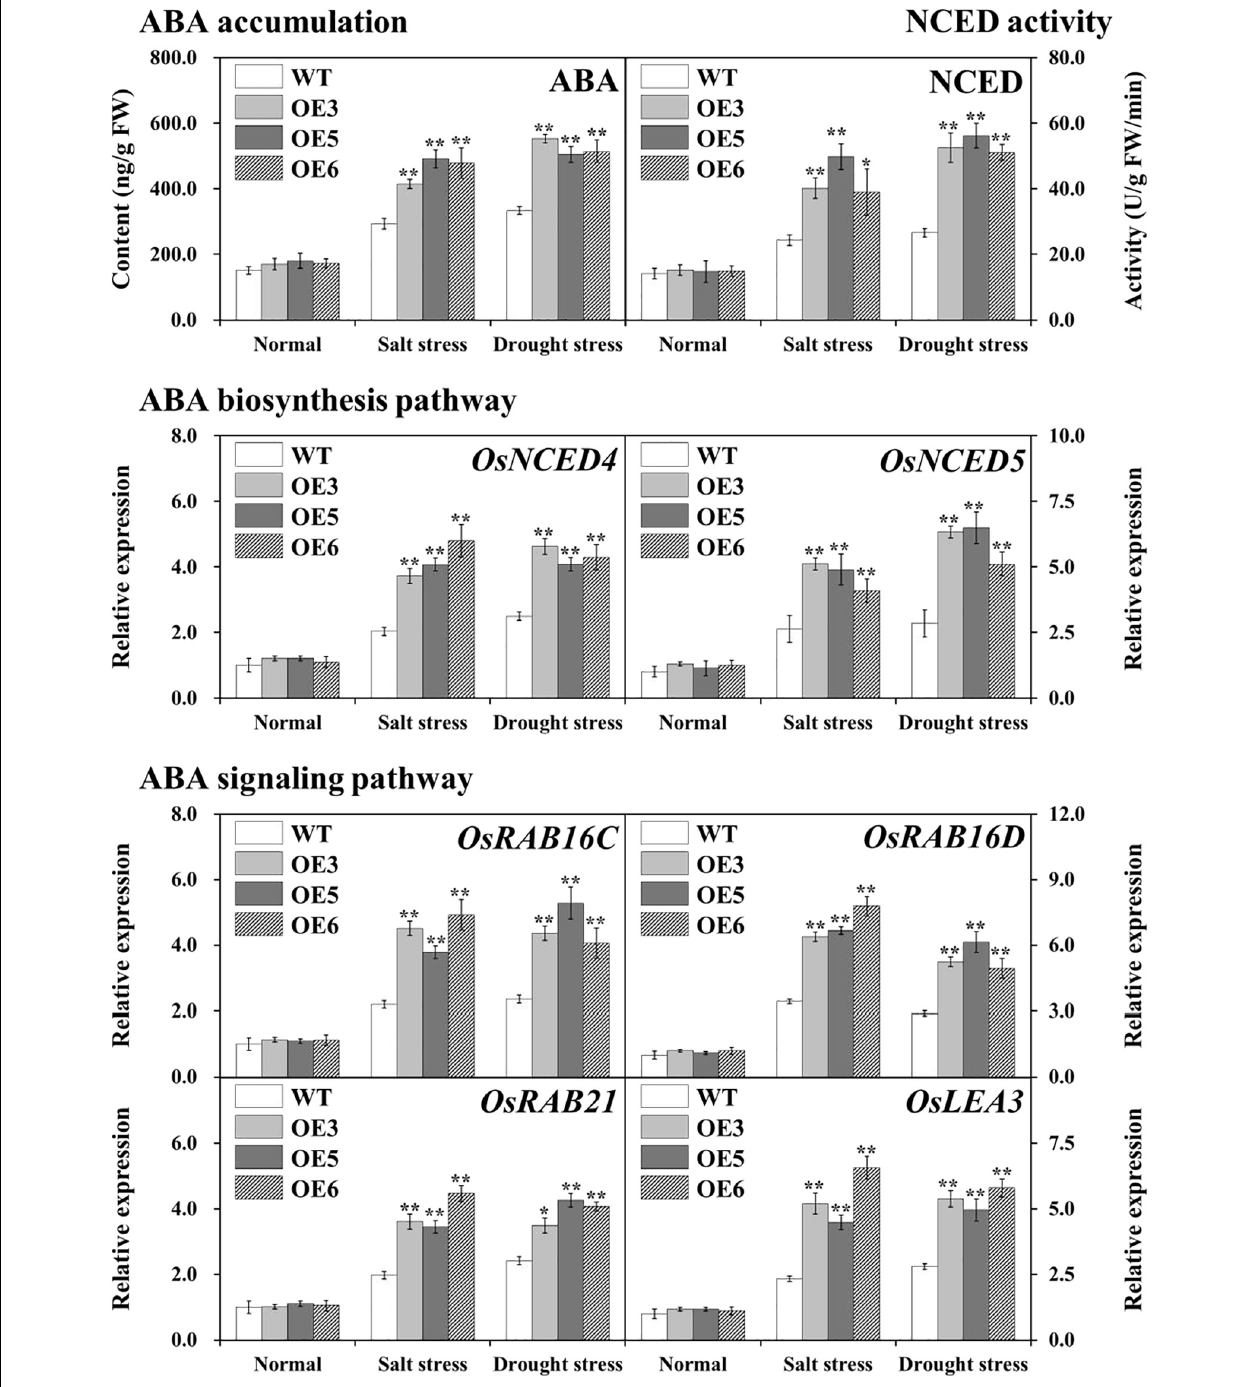
FIGURE 6 | ABA accumulation and the expression of ABA biosynthesis and signaling pathways marker genes in the leaves of overexpressing OsIAA18 and WT plants under salt and drought stresses. Data are presented as means ± SE ( n = 3). The values of * and ** indicate a significant difference from that of WT at P < 0.05 and < 0.01, respectively, by Student’s t